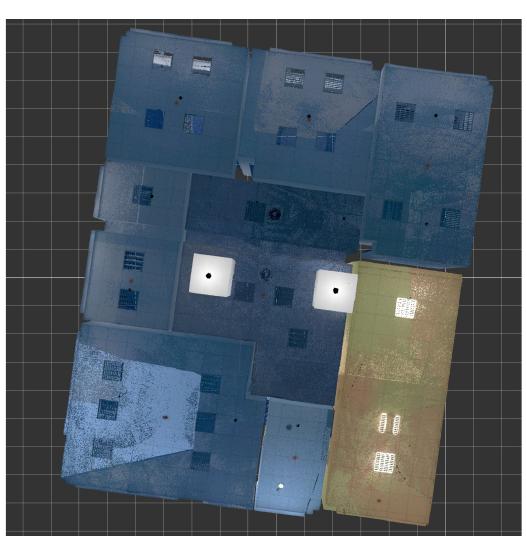
Figure 1. Laser scan of an unfurnished o ffi ce build- ing, consisting of 85M points, top